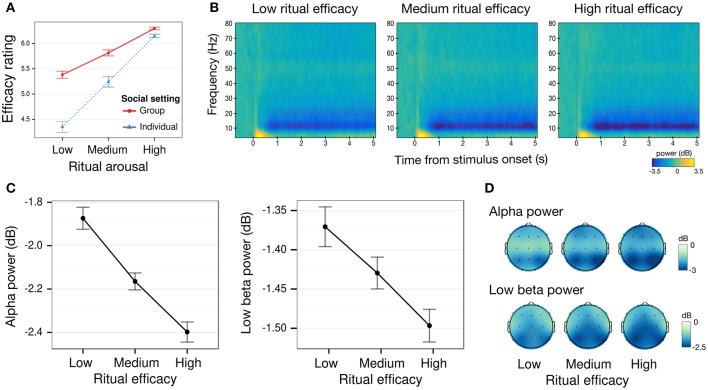
Behavioral and oscillatory power correlates of the perceived efficacy of Chinese spirit-medium rituals. (A) Mean behavioral ratings of perceived ritual efficacy by arousal and social setting. Emotionally arousing rituals were rated as significantly more efficacious. Efficacy ratings for low arousal rituals were marginally higher when viewed in a group of three participants than individually. (B) Time-frequency plot of mean power changes from baseline for low, medium, and high efficacy rituals. (C) Mean alpha (8 – 12 Hz) and low beta (13 – 20 Hz) power decrease from baseline over all electrodes by perceived ritual efficacy, showing decreasing power for increasing efficacy (1 – 5 s post-stimulus onset window) (D) Alpha and low beta power topography (1 – 5 s post-stimulus onset window). All error-bars indicate within-participant standard error of the mean. Where there was no significant difference between individual and groups settings, their data were aggregated before plotting.